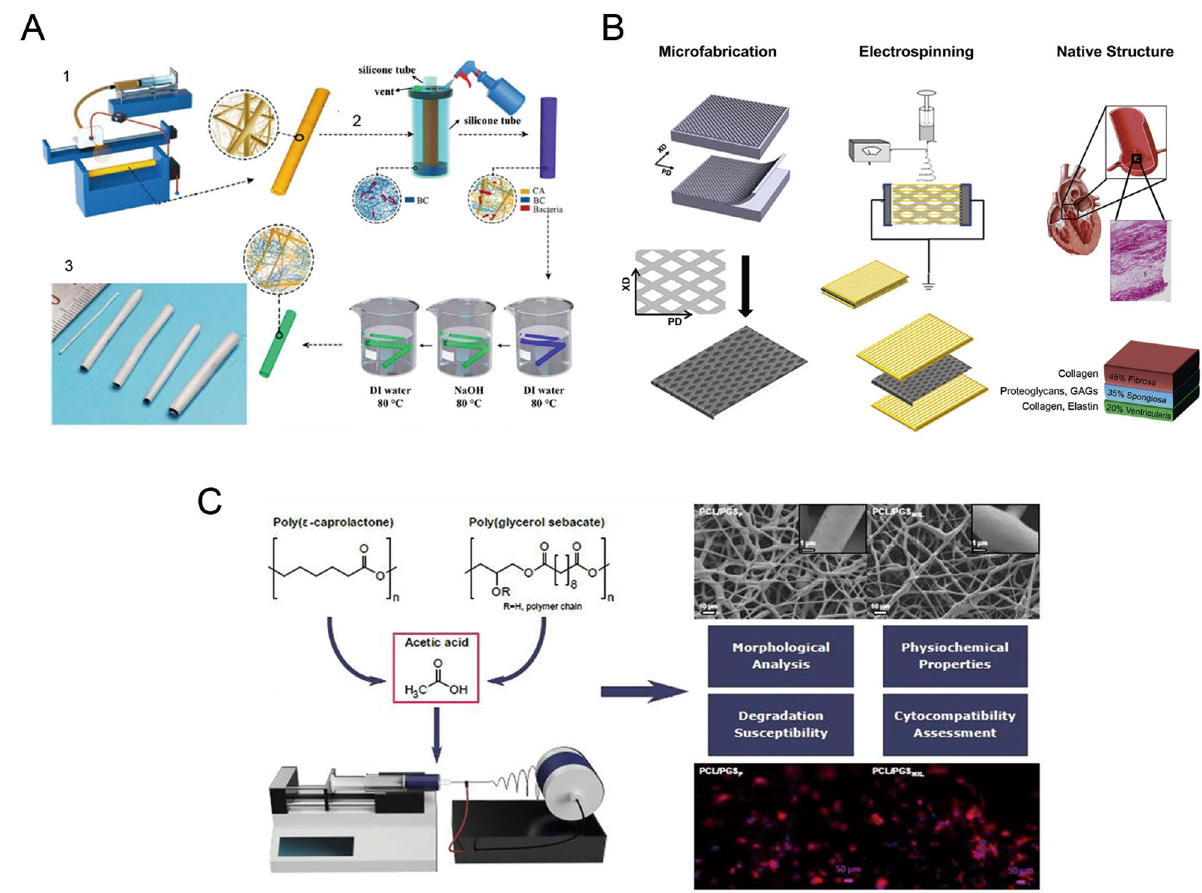
aluminum electrodes and connected to the ground. PGS/Polycap- rolactone (PCL) fibers were placed on both sides of the PGS layer for electrospinning. The use of this fibrous membrane stent in valve repair [52]. Reprint with permission from Elsevier; c PCL and PGS fibers have been used in cardiac tissue engineering [57]. Reprint with permission from